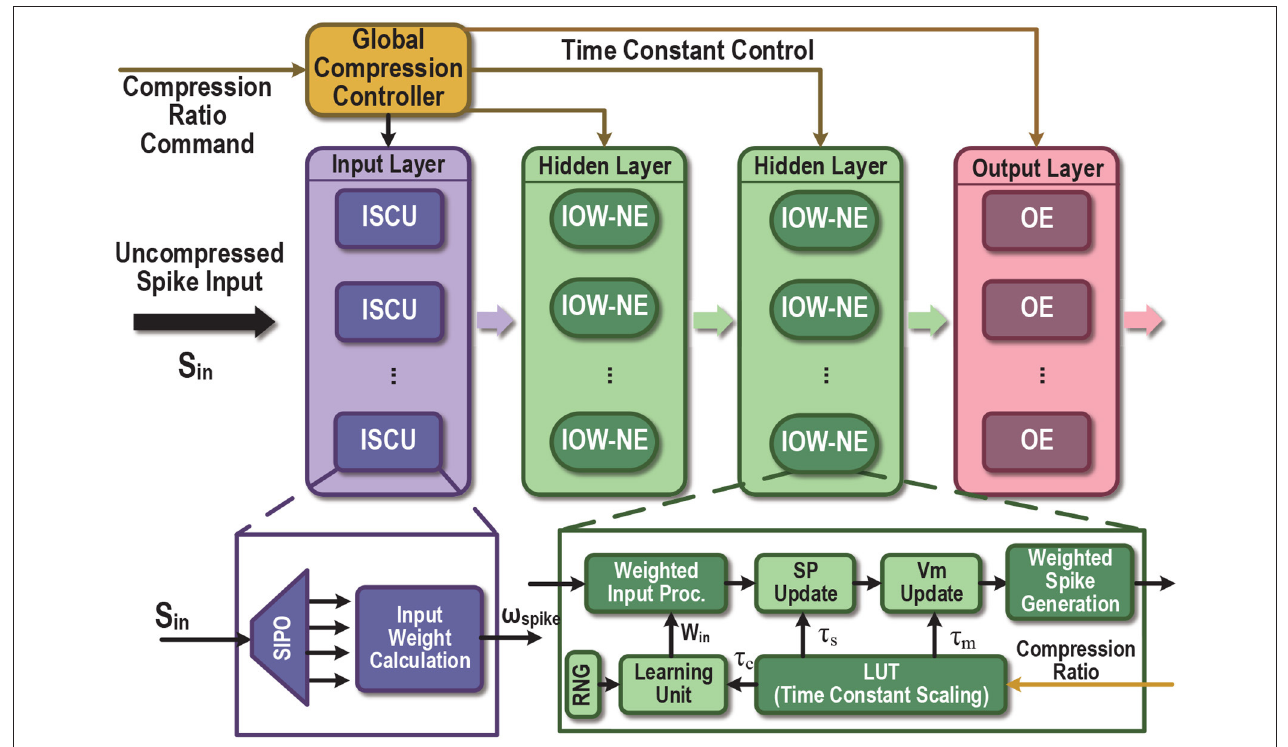
FIGURE 6 | Proposed time-compressed SNN architecture with programmable compression ratio (PTC-SNN). ISCU, input spike compression unit; SIPO, serial-in and parallel-out; IOW-NE, input-output-weighted spiking neuron element; SP, synapse response; NE, regular binary-input-output neuron element; Vm, membrane potential. The LUT enables programmable scaling of time constants of the neuron/synaptic models and the learning unit.